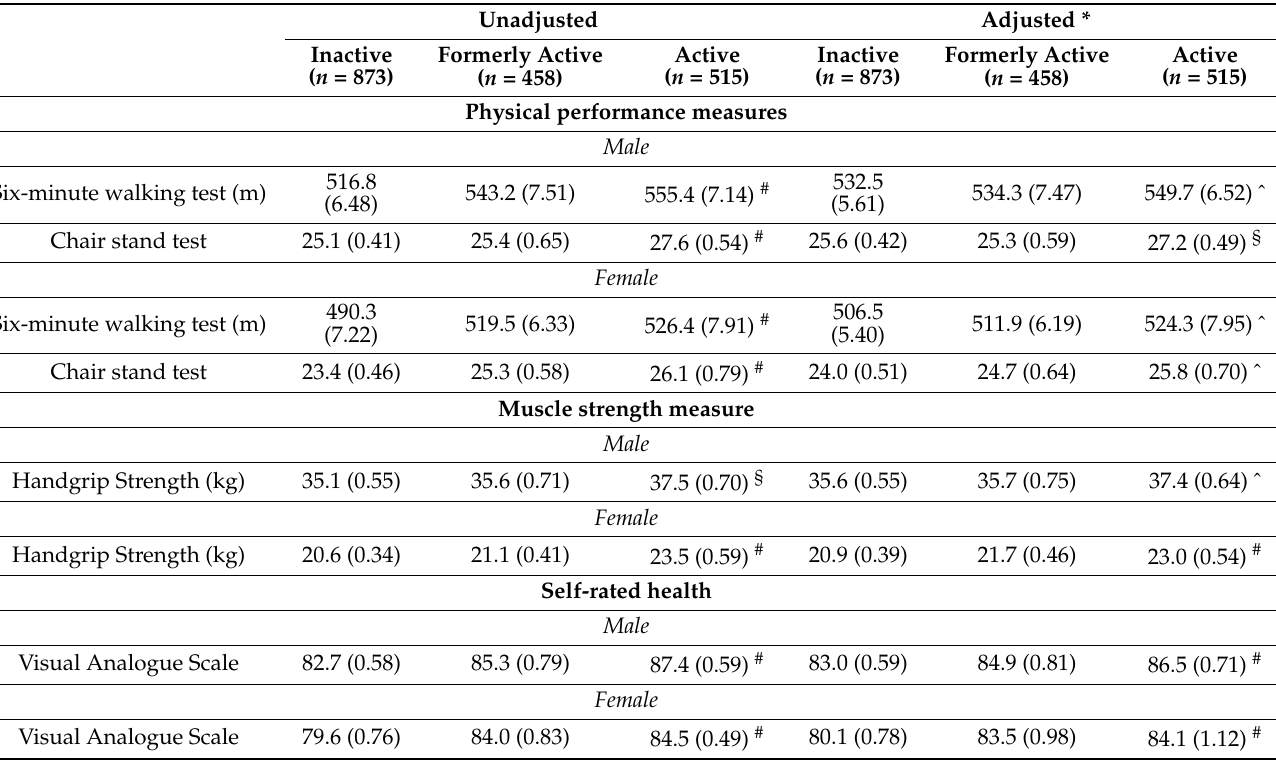
Table 2. Unadjusted and adjusted * means (SE) of physical performance, muscle strength measures, and self-rated health in men and women according to physical activity